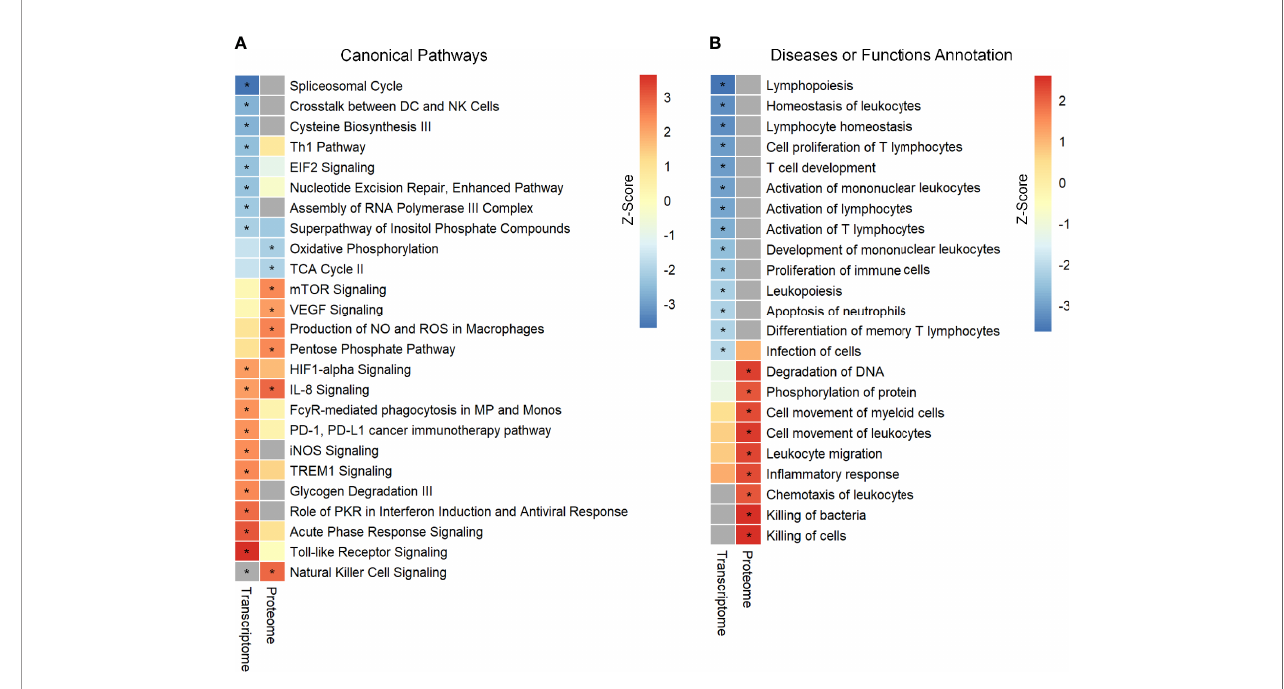
FIGURE 1 | Identi fi cation and comparison of pathways enrichment analysis in transcriptome and proteome from septic patients. (A) The canonical pathways signi fi cantly enriched by DEGs and DEPs. (B) Ingenuity biological function activity analysis. * Represents B – H p -value <0.05 and a z -score >2 (pathway increased) or z -score < − 2 (pathway decreased). B – H p -value were determined using Fischer ’ s exact test and adjusted for multiple comparisons by Benjamini-Hochberg